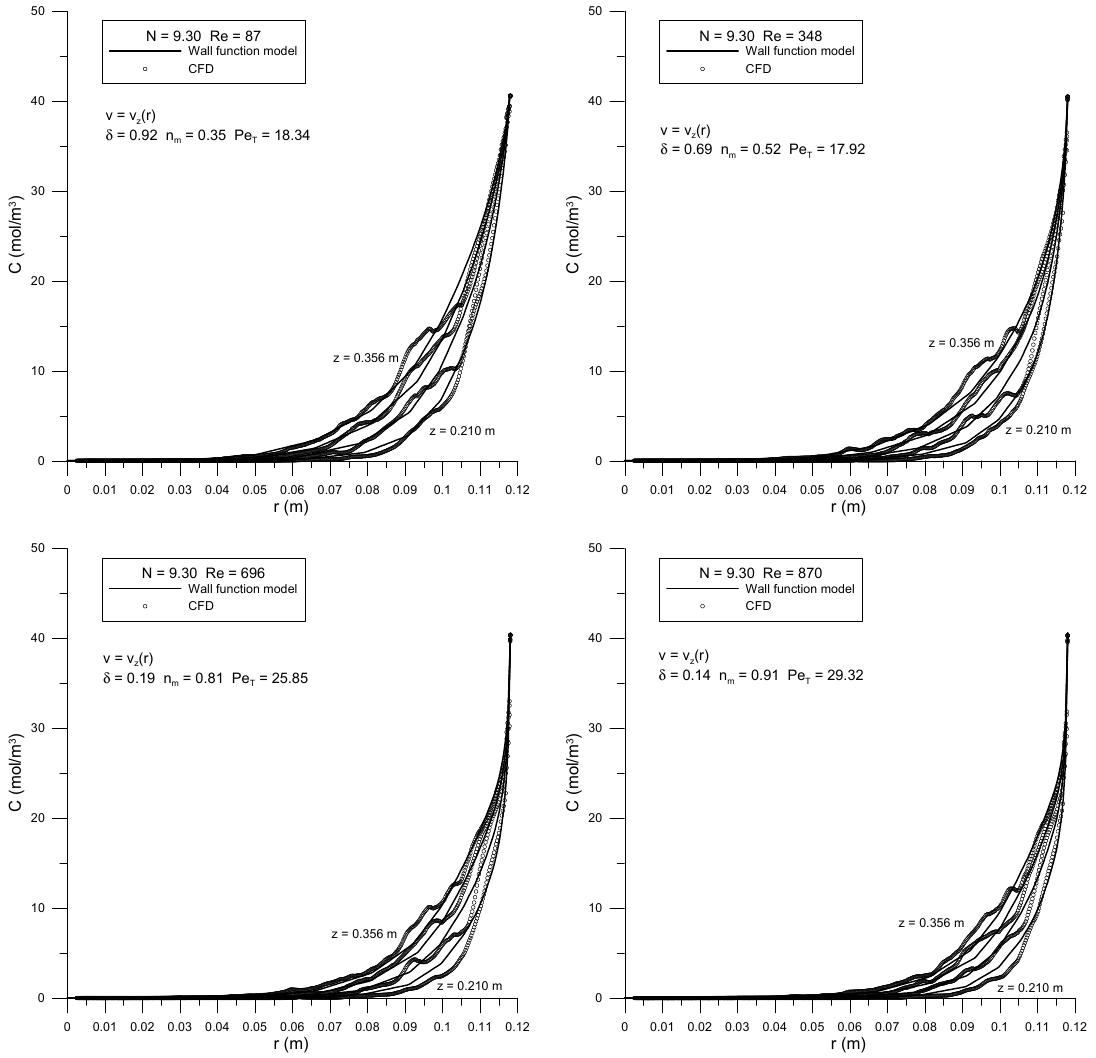
Figure 13. Results for three-parameter wall function model using D T ( r ) and v z ( r ) for the case N = 9.30, all four values of Re, each fitted to all four bed depths simultaneously.